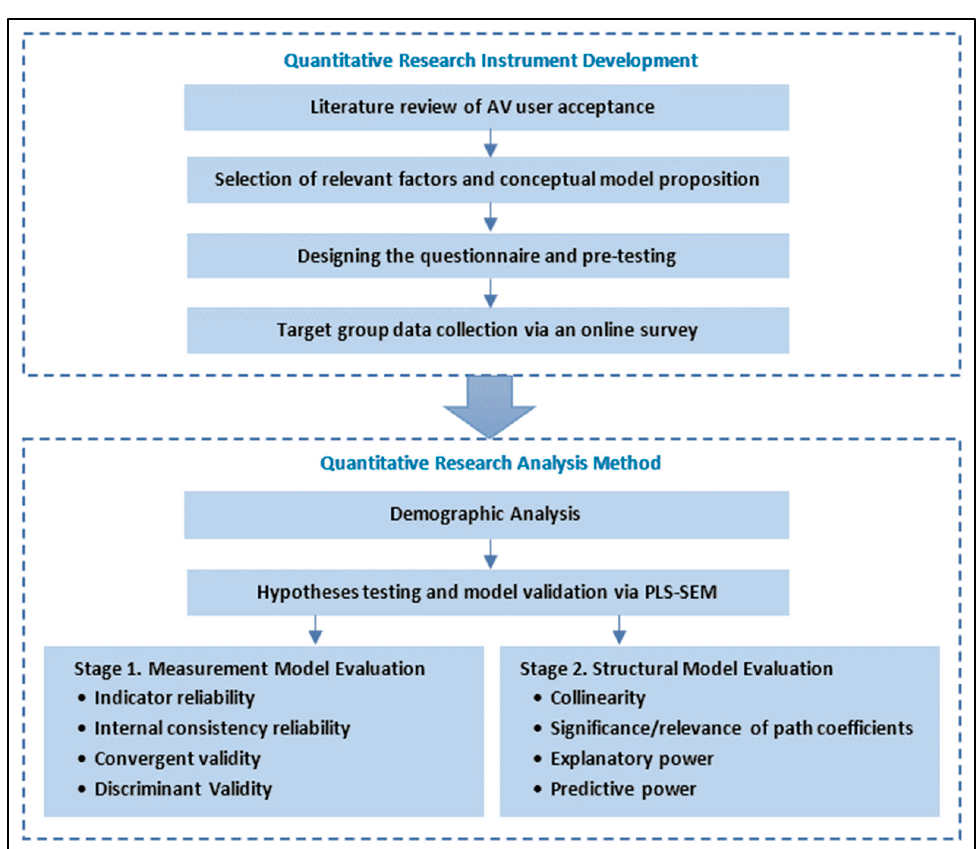
Figure 1. Study design flowchart.